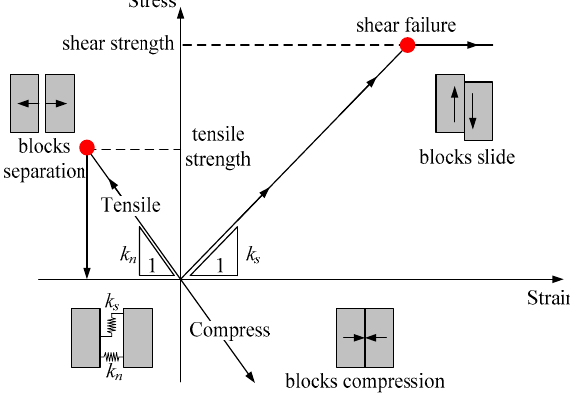
Figure 7. The constitutive behavior of the contact [61].